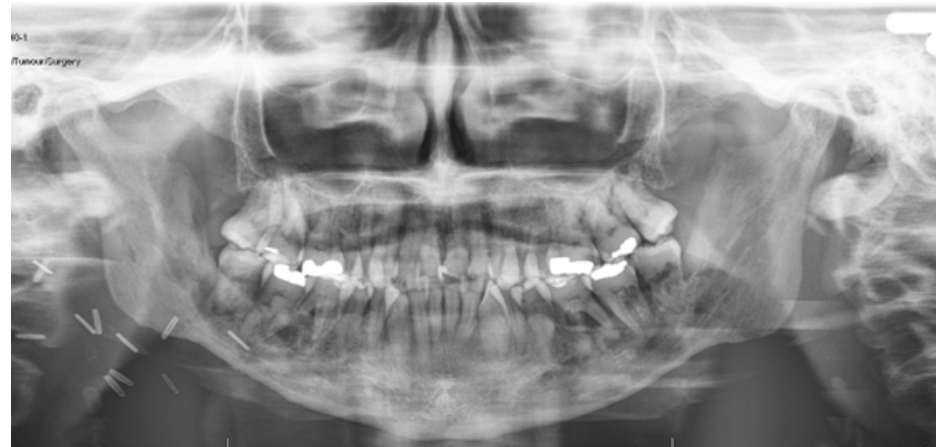
Figure 1. Pre-operative OPG.